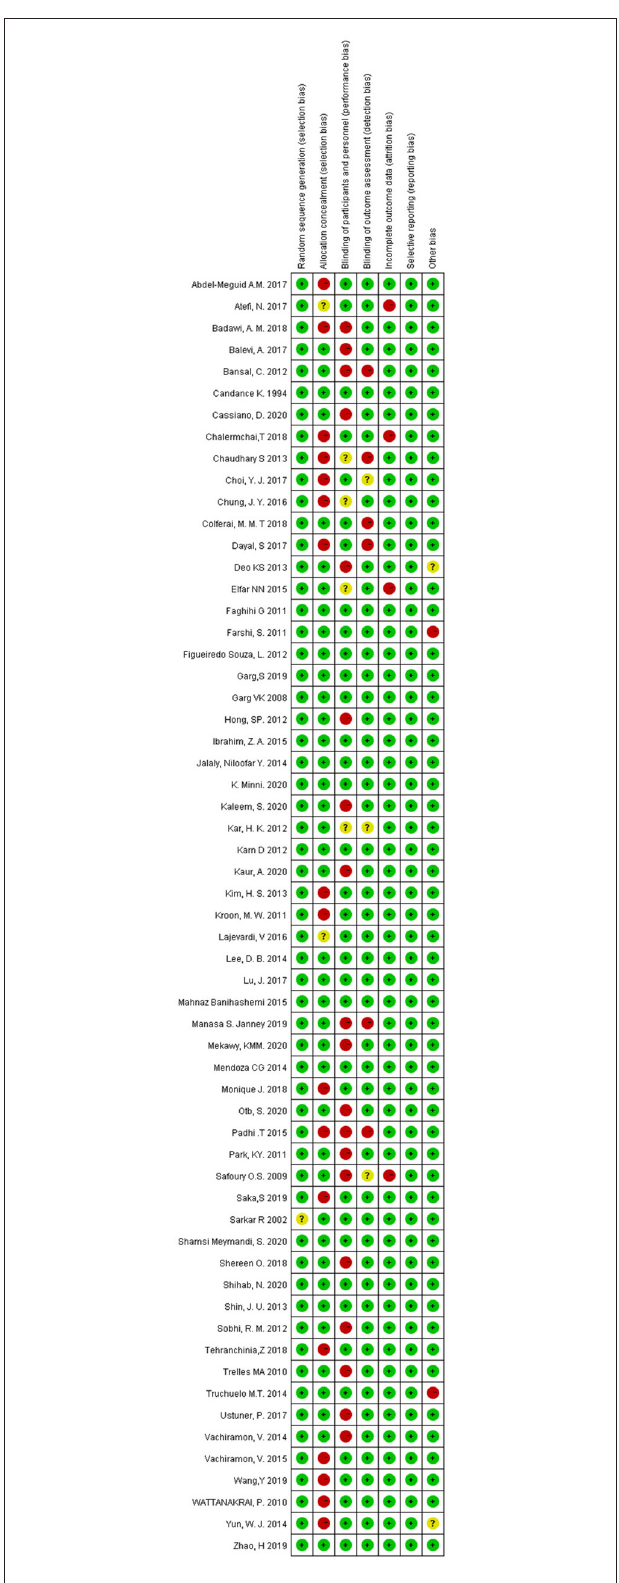
FIGURE 3 | Risk of bias summary for individual